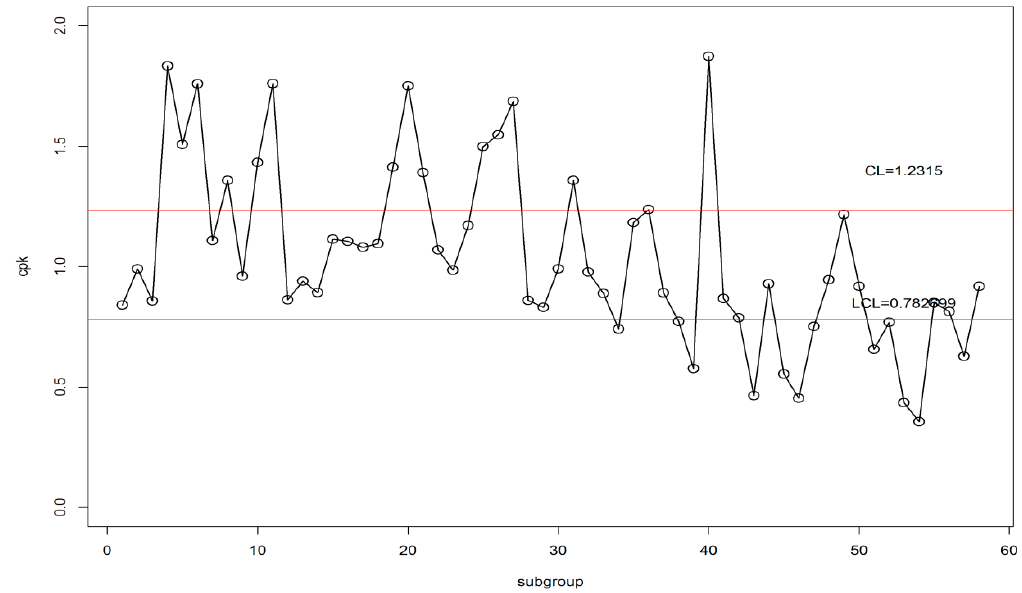
Figure 3. Proposed log-normal MAD control chart for simulated data.